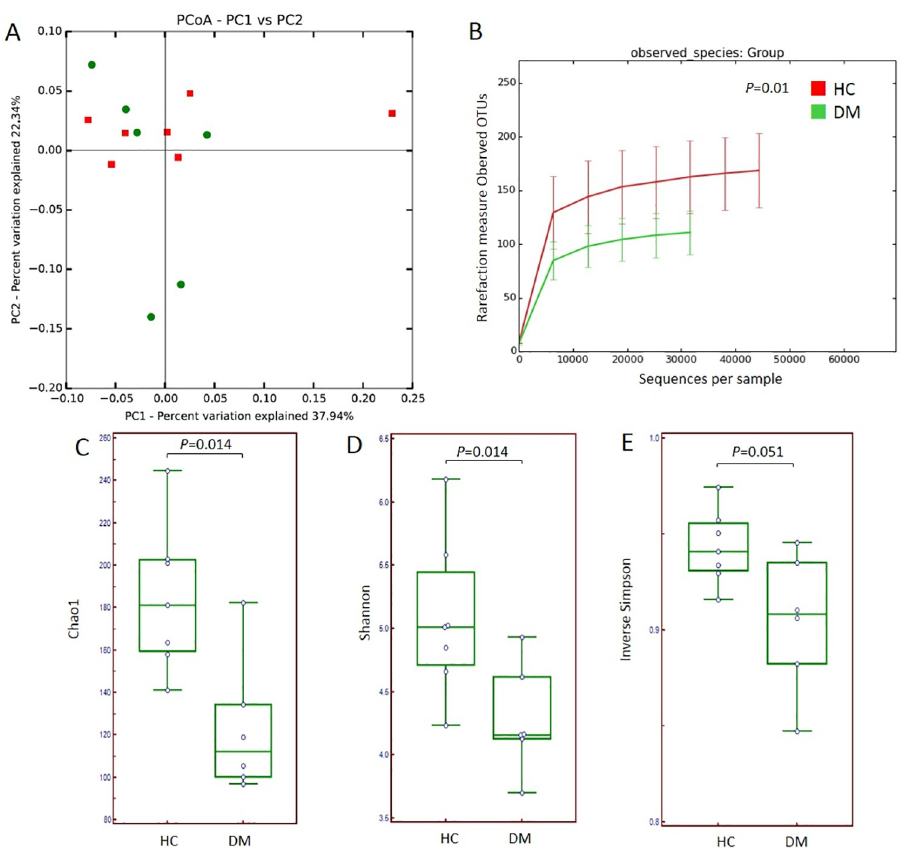
Fig 4. Comparison of variation and diversity indices between healthy respiratory control (HC) and diabetic subjects (DM). (A) PCA plot for HC (red) and DM (green) (B) Rarefaction curve based on observed OTU by sampling group. (C) Chao1 box plots. (D) Shannon box plot. (E) Inverse Simpson box plot. https://doi.org/10.1371/journal.pone.0259596.g004 The percentage variance explained for each axis (PC1 and PC2) in PCA were 37.94% and 22.34%, respectively (Fig 4A). The median number of OTUs for DM and HC were 109 and 169, respectively, where the number in DM samples was significantly lower than in HC sam- ples (Mann-Whitney test, P = 0.010) (Fig 4B). Diversity indices, Chao1 ( P = 0.014) and Shan- non ( P = 0.014), were significantly lower in DM samples than HC samples (Mann-Whitney test) while the Inverse Simpson index showed a P value of 0.051 (Table 2 and Fig 4C–4E).